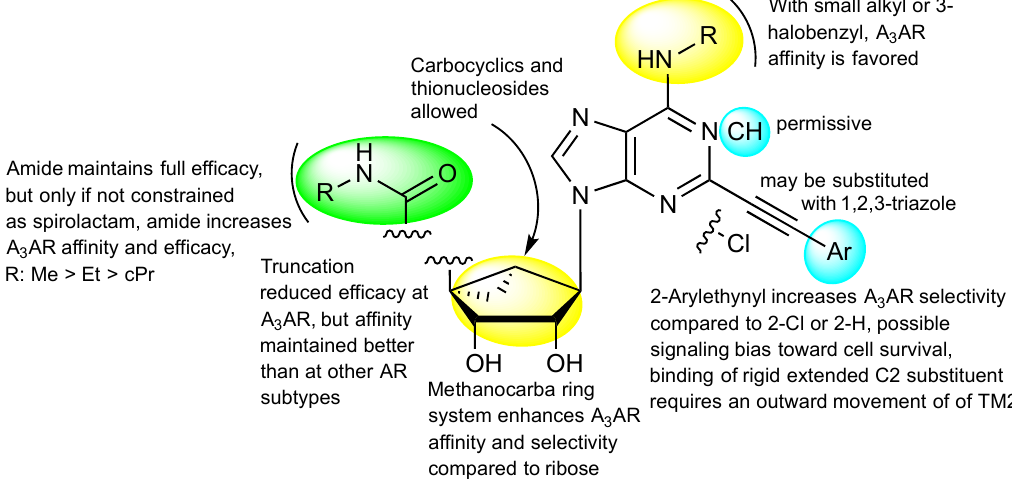
Figure 10. A general SAR summary of nucleosides at the hA 3 AR, including effects on affinity, efficacy, selectivity and receptor conformation.